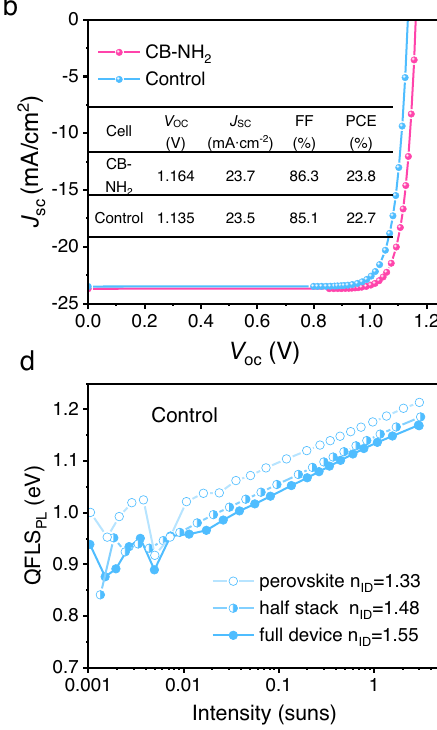
Fig. 5 | Pseudo- JV and ef fi ciency potential. a Intensity-dependent quasi-Fermi level splitting (QFLS) measurement. b Pseudo JV curves from intensity-dependent QFLS of the full devices. Intensity-dependent QFLS measurements for neat per- ovskite, perovskite/C 60 half stack, and full devices of c CB-NH 2 -based sample and